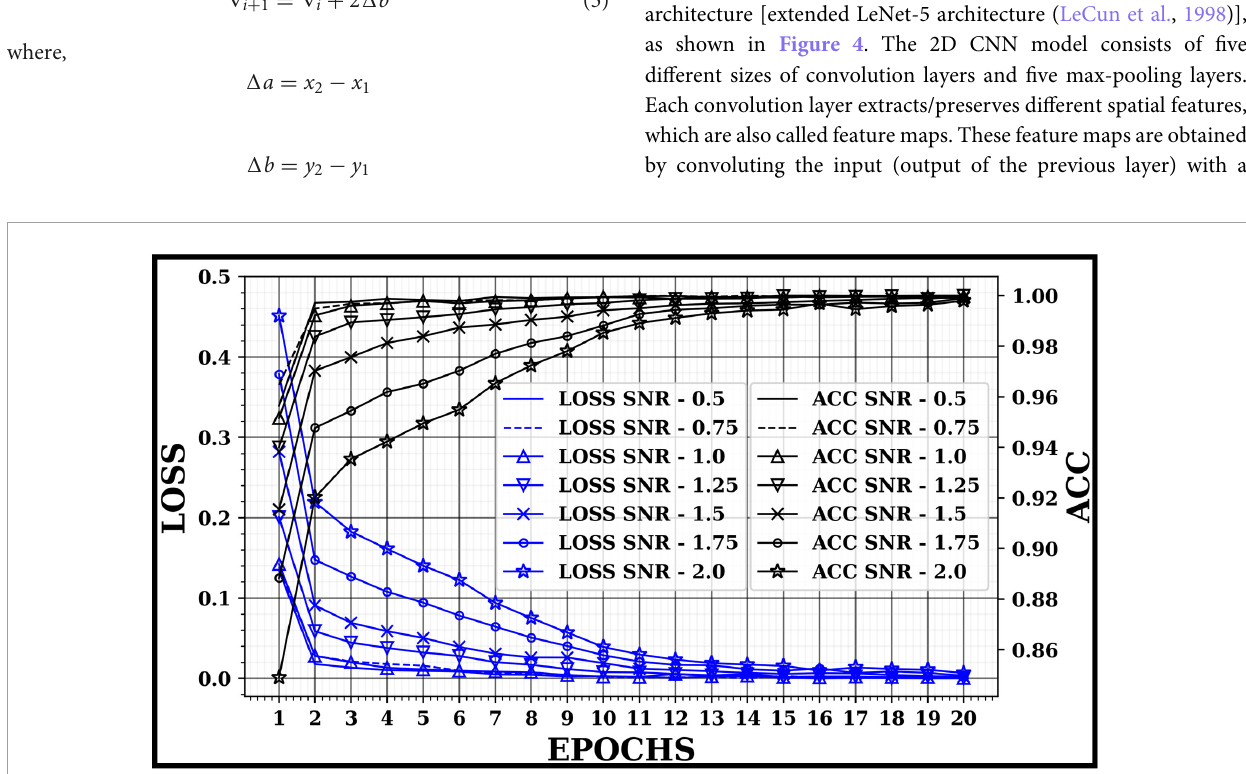
FIGURE5 Loss vs. no. of epochs per SNR’s and accuracy vs.